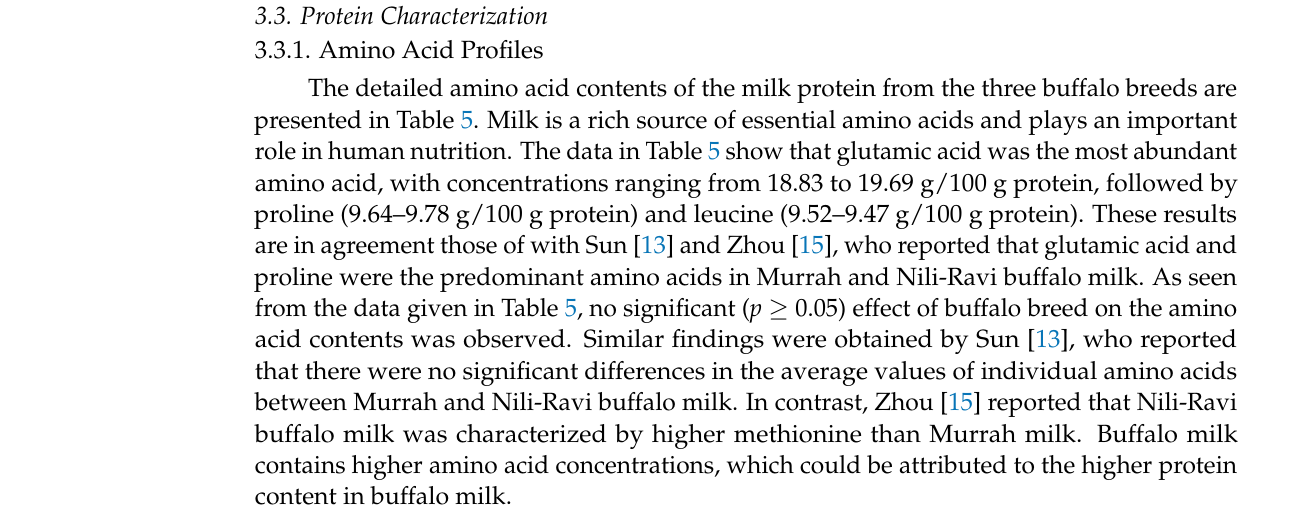
Table 5. Amino acid (g/100 g protein) profile of milk from different buffalo